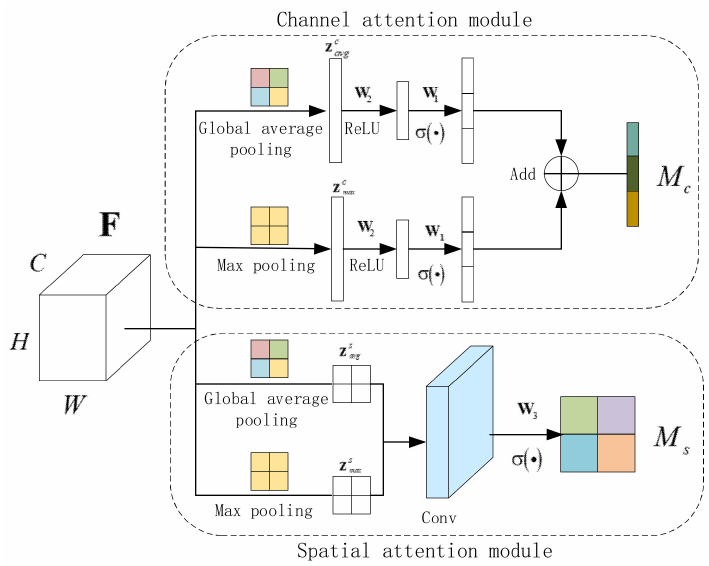
Figure 6. Illustration of the attentional message integrated module